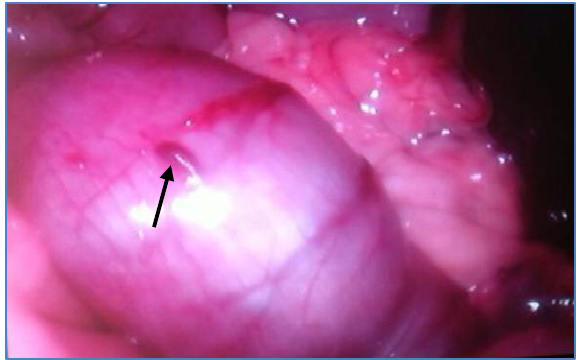
Figure, 3: Laparoscopic image of pelvic cavity, shows colonic incisional sites (arrow) with no adhesion formation (grade zero), 30 th day post-operation in group B.